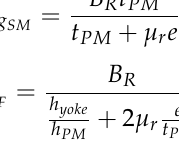
Figure 12. Haliade-X 12 MW nacelle (courtesy of GE) [57]. The RF machine may be divided into many categories based on the placement of the permanent magnet, the rotor design, the rotor position, the stator core and the winding distribution. The permanent magnet can be surface mounted, inserted or buried. In a surface-mounted PMSG, the permanent magnets are glued to the surface of the rotor; however, to provide acceptable flux density in the airgap, it is necessary to use high- energy magnets (e.g., Alnico, NbFeB), while in buried PMSG with flux concentration, the flux density in the airgap is higher than the remanent flux density of the permanent magnet. Equations (5) and (6) give an estimation of airgap’s flux density for a surface- mounted PMSG, B g and for a concentration flux PMSG (neglecting the effects of SM stator slots and leakage within the rotor), B g , respectively [118]. Notice that in order CF to have the usual range of induction in large machines (0.8 T–1.1 T), the remanence flux density should be at least 1 T for the surface-mounted topology, whereas for the flux concentration PMSG, with convenient choice of the permanent magnet dimensions, it is possible to have high flux density with a low-cost permanent magnet such as ferrite ∼ = (with B r [0.20–0.46] T